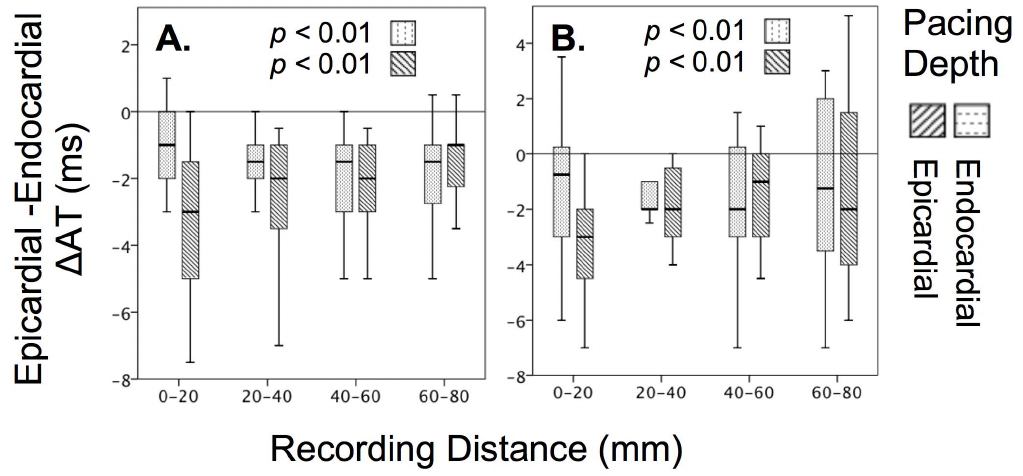
Figure 5. Transmural comparison of activation time between the epicardial and endocardial layer (shown as difference D AT) at various distances from the stimulus site during endocardial and epicardial pacing. Comparisons shown are: A. Unipolar and B. Bipolar minimally filtered electrograms.